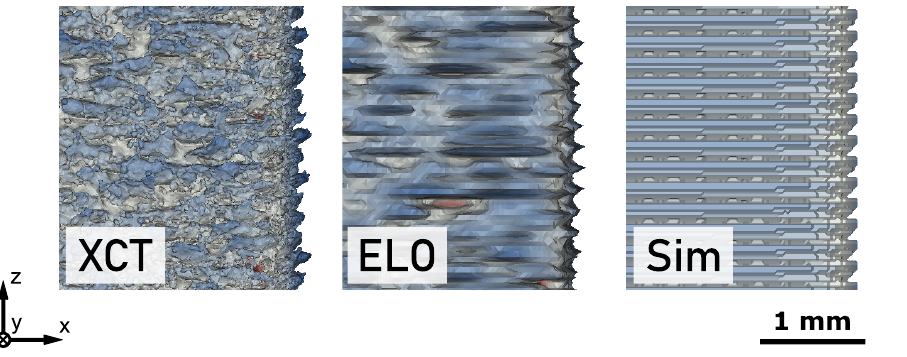
Figure 5. Surface roughness of part A observed in XCT, ELO and simulation